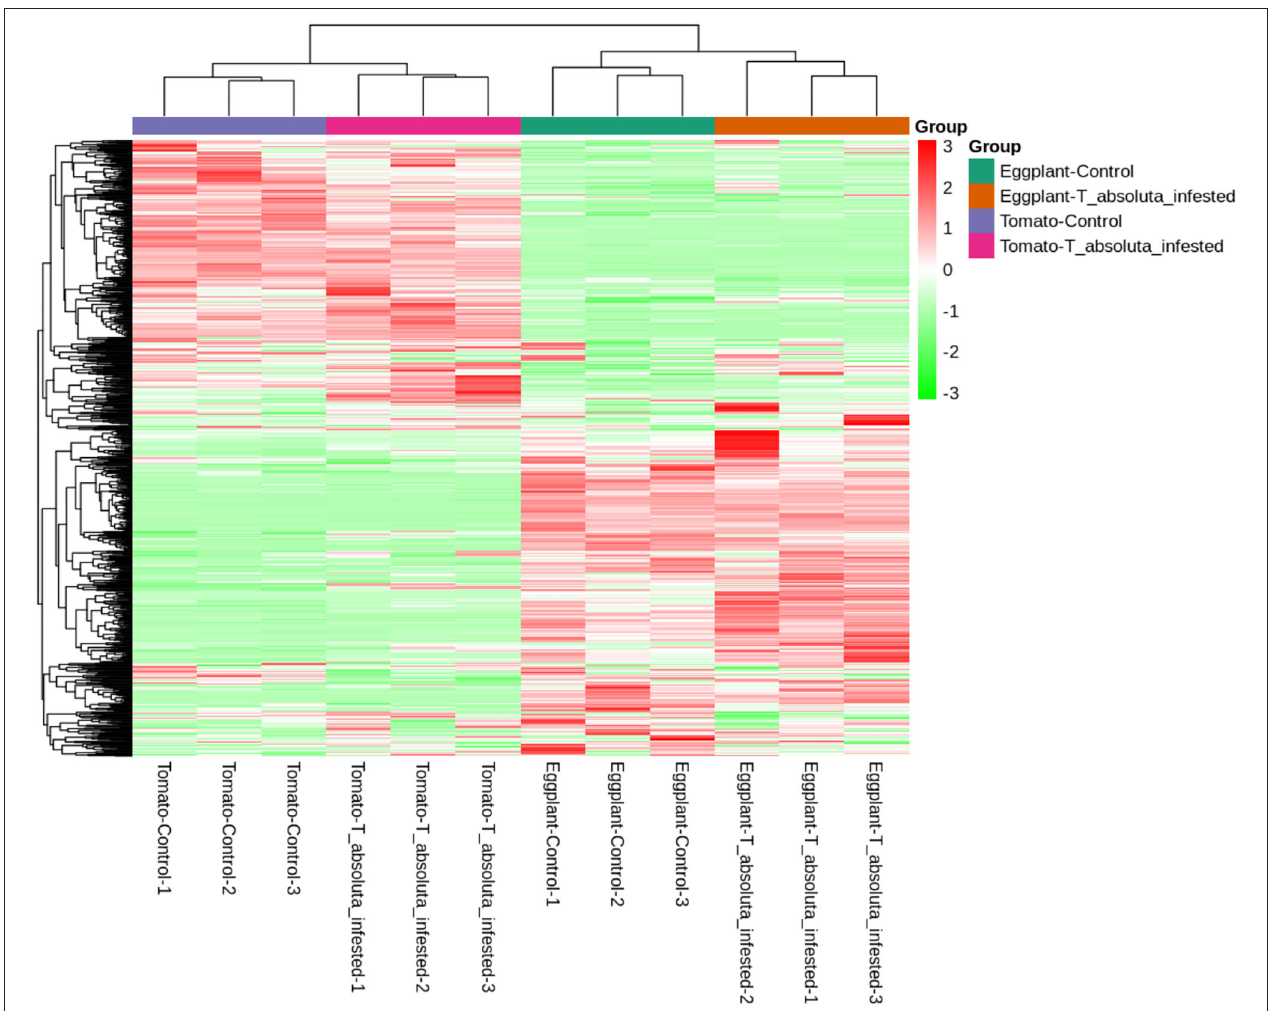
FIGURE 5 | Hierarchical clustering based on the ion intensity of primary/secondary metabolites from the leaves of tomatoes and eggplants. All analyses were done in triplicates: Eggplant-Control (1–3), Eggplant- T. absoluta infested (1–3), Tomato-Control (1–3), and Tomato- T. absoluta infested